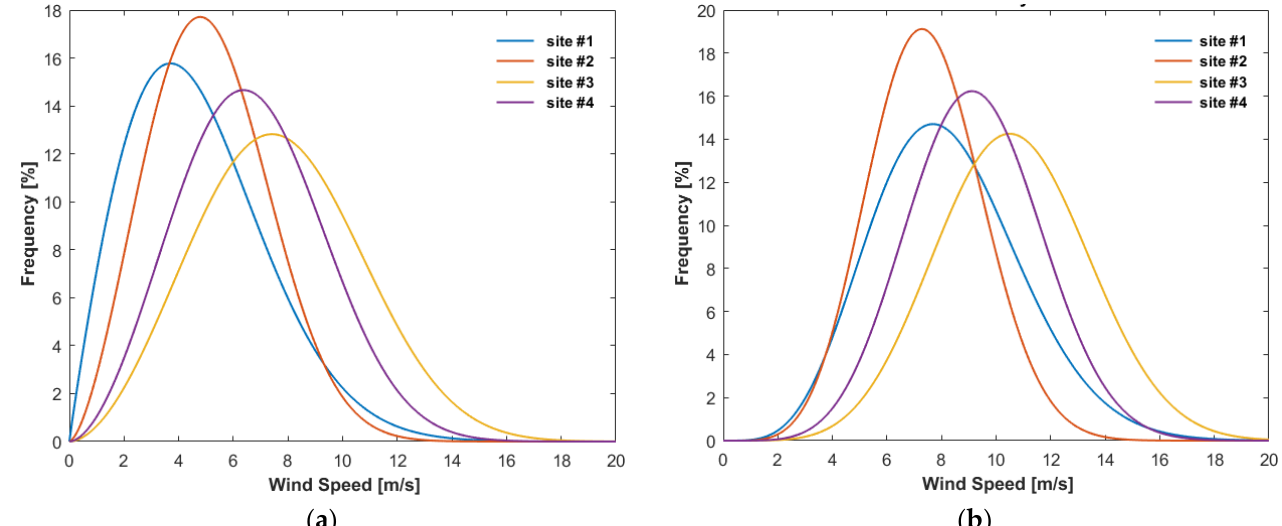
Figure 1. Weibull probability distribution of low-to-medium wind characteristics of four sites around Mekelle. ( a ) Wind speed distribution. ( b ) Wind power density distribution.